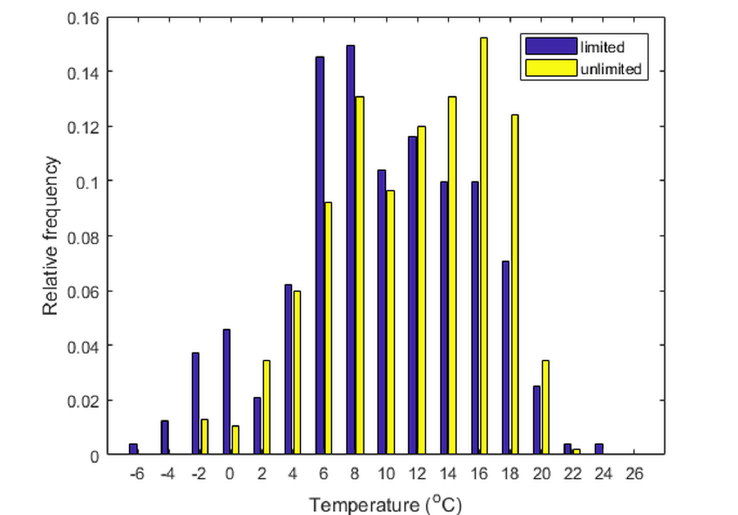
Figure 7. Relative frequency of the temperature at the time of observation (1 observation per hour) during the limited and unlimited transport events. The mean temperature for unlimited and limited events was 12.4 ◦ C (with a standard deviation of 5.1 ◦ C) and 10.5 ◦ C (with a standard deviation of 5.9 ◦ C),